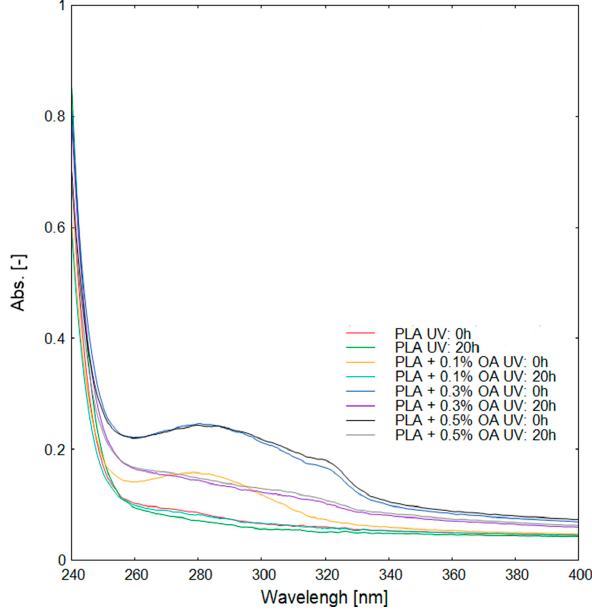
Figure 4. UV-VIS spectra of PLA materials containing different contents of OA before and after photodegradation.